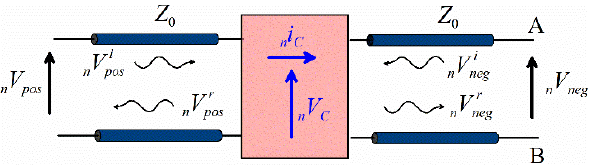
Figure 6. Circuit involving two opposite link lines associated with a common voltage, n V c , and a common current, n i c . The box at the center denotes a formal coupling with other lines also present in the shunt node associated with n V c , and the series node associated with n i c . The voltage on the line contributing positively to n i c is denoted as n V pos , and the volt- age on the opposite line is denoted as n V neg . It can be seen that the reflected pulses can be obtained using the following simple equations [27]: